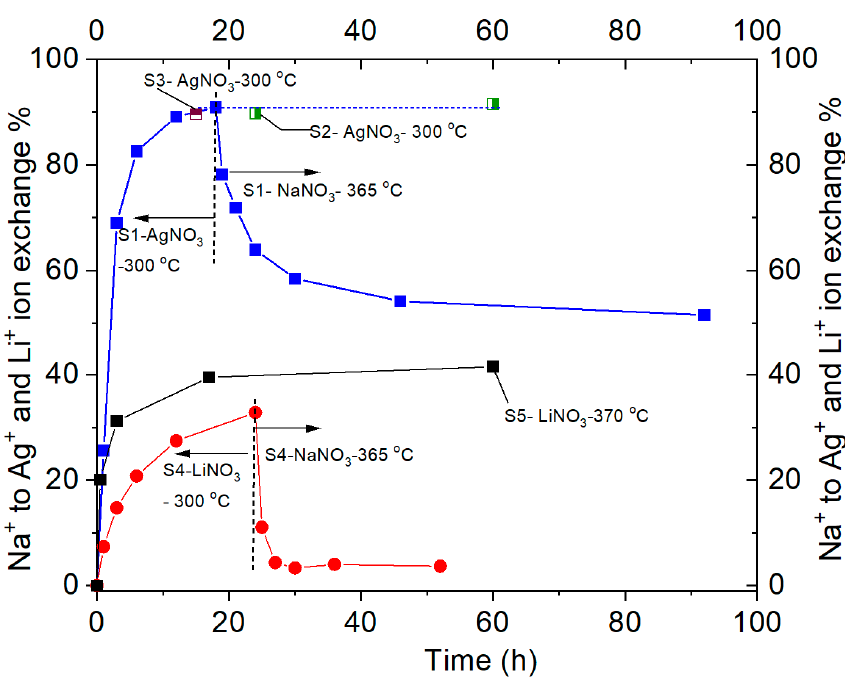
Figure 5. Measured Ag + /[Ag + + Na + ] and Li + /[Li + + Na + ] ratios after ion exchange in AgNO 3 and later after reverse ion exchange in NaNO 3 as a function of time from five converted samples. Li ion exchange was conducted at two temperatures; 300 °C and 370 °C. Table 1. Summary of AgNO 3 ion exchange & reverse NaNO 3 Ion exchange experiment data.